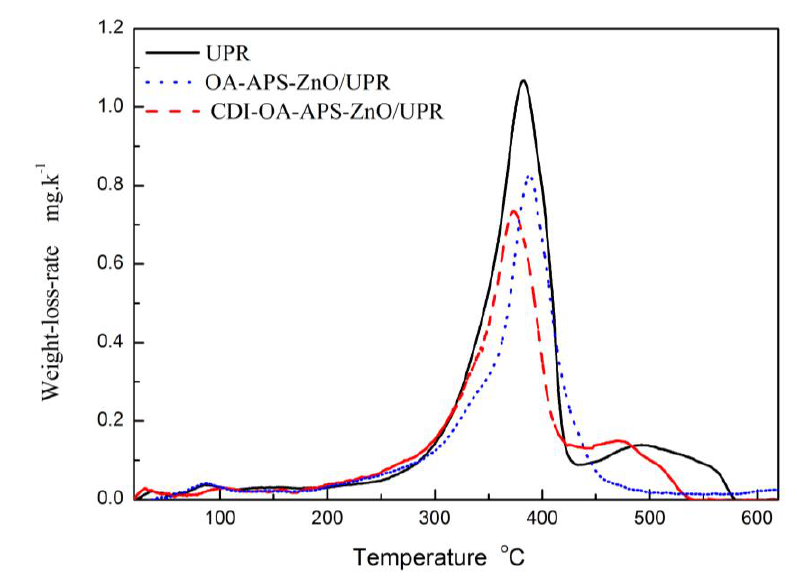
Figure 5. Loss-weight rate of pure UP, OA–APS–ZnO/UP and CDI–OA–APS–ZnO/UP.